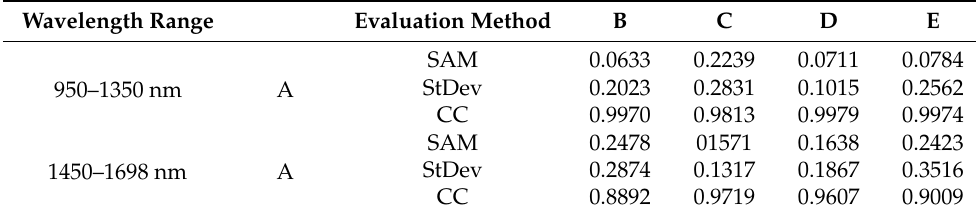
Table 2. Comparison of Spectral Similarity in Near Infrared